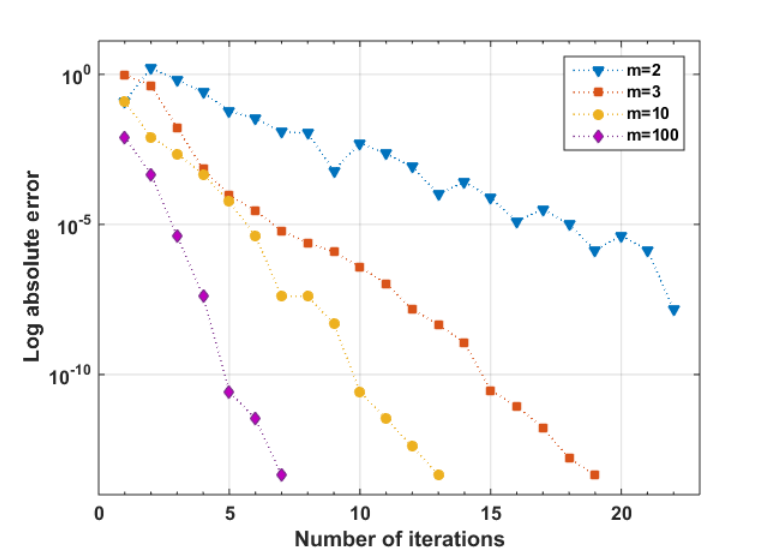
Figure A1. Log errors for the bisection ( m = 2) and multisection method for approximating the root of